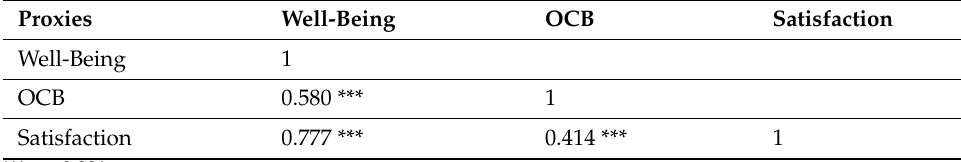
Table 3. Correlations between Sustainable Careers proxies. Proxies Well-Being OCB